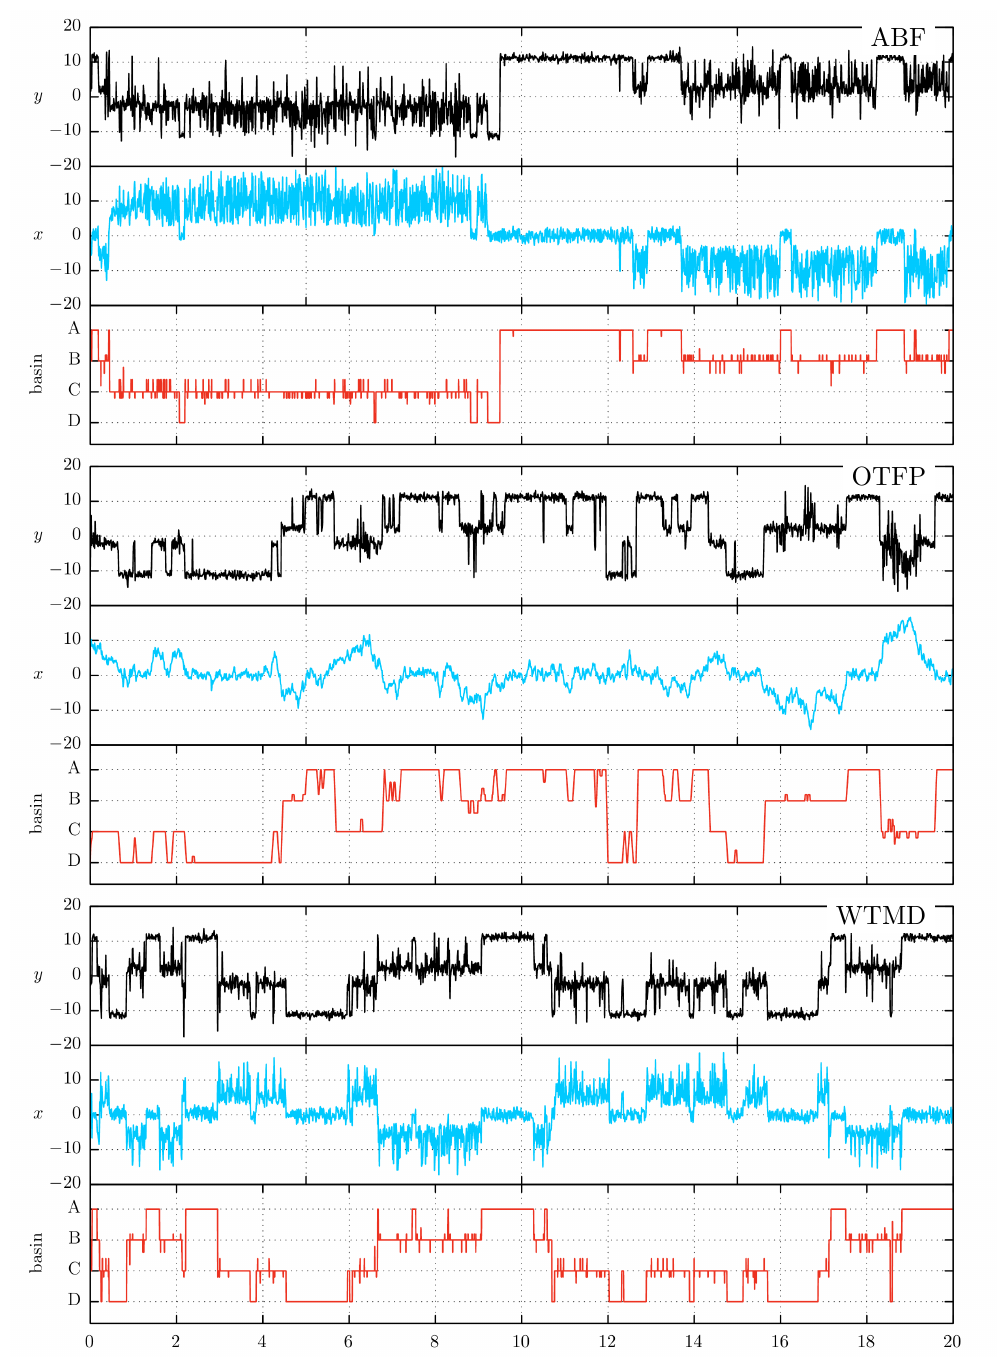
Figure 10. The position trace of representative ABF, OTFP and WTMD simulations associated with the results shown in Figure 9. For each method, x , y and basin assignation are shown in black, blue and red